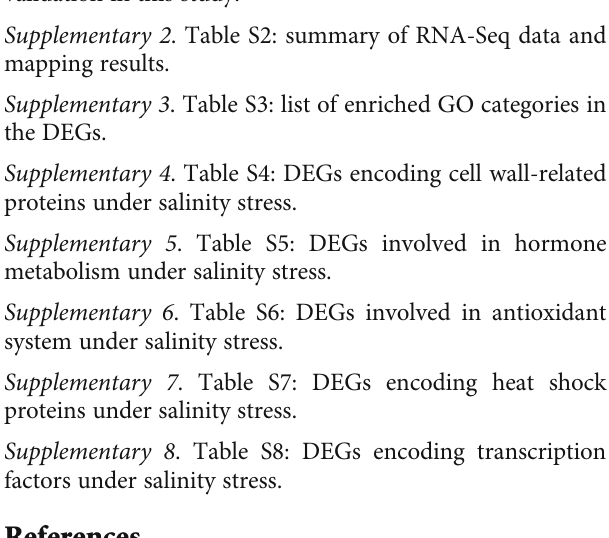
Supplementary 1 . Table S1: designed primers for qRT-PCR validation in this study. Supplementary 2 . Table S2: summary of RNA-Seq data and mapping results. Supplementary 3 . Table S3: list of enriched GO categories in the DEGs. Supplementary 4 . Table S4: DEGs encoding cell wall-related proteins under salinity stress. Supplementary 5 . Table S5: DEGs involved in hormone metabolism under salinity stress. Supplementary 6 . Table S6: DEGs involved in antioxidant system under salinity stress. Supplementary 7 . Table S7: DEGs encoding heat shock proteins under salinity stress. Supplementary 8 . Table S8: DEGs encoding transcription factors under salinity